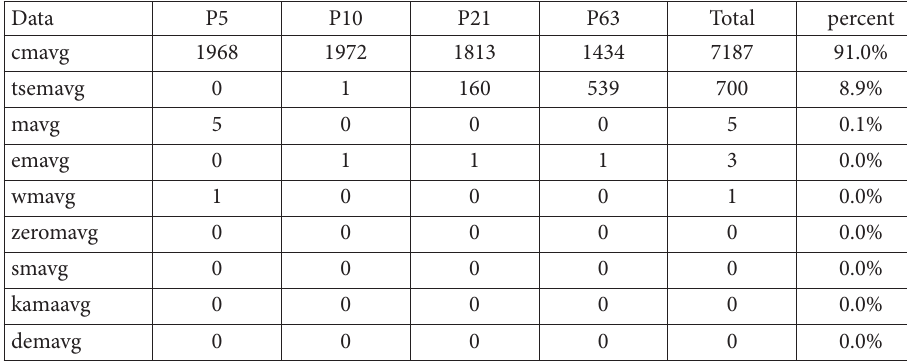
Table 4. Summary of stock